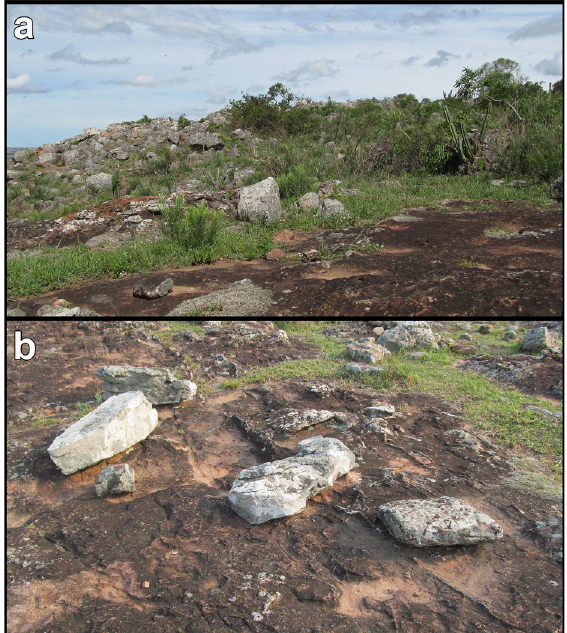
Figure 2. Rocky environments of the hills of Paraje Tres Cerros (a) where the microhabitat of Homonota taragui is located (b). This microhabitat is formed by large blocks of rocks where smaller rocks are supported (rock-rock